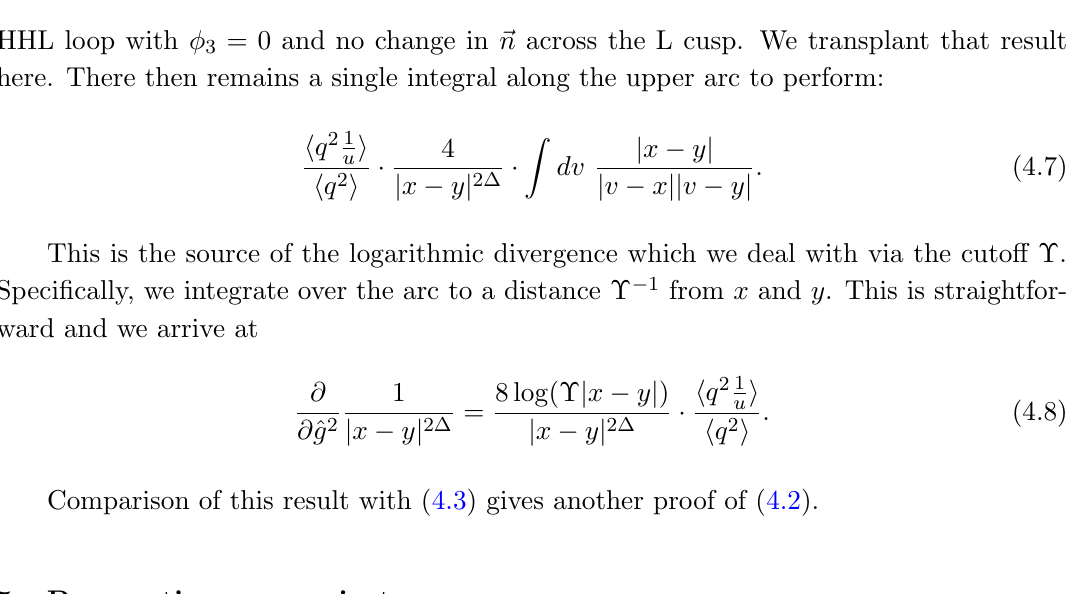
Figure 4 . Propagators between the Lagrangian at u and scalar (cid:12)elds at points v , w on the loop are drawn in purple. Integrating over u gives rise to an e(cid:11)ective propagator between the arcs drawn in